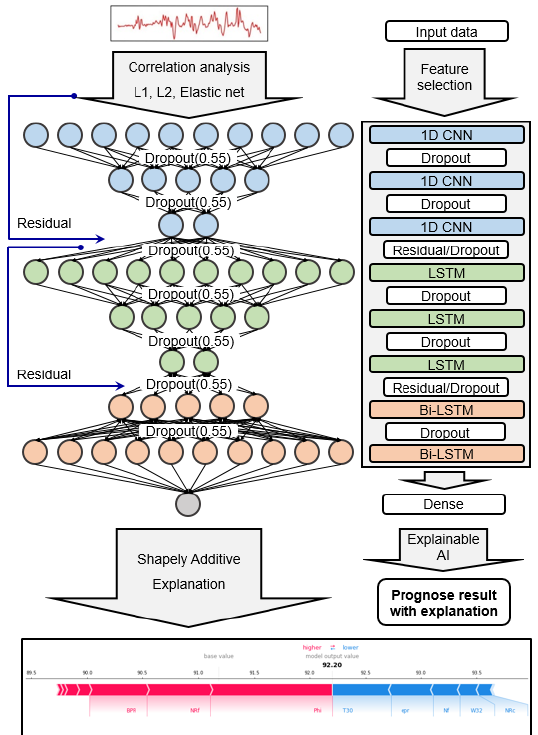
Figure 3. Proposed deep-stacked convolutional bidirectional LSTM model with dimensionality reduction and explainable artificial intelligence.